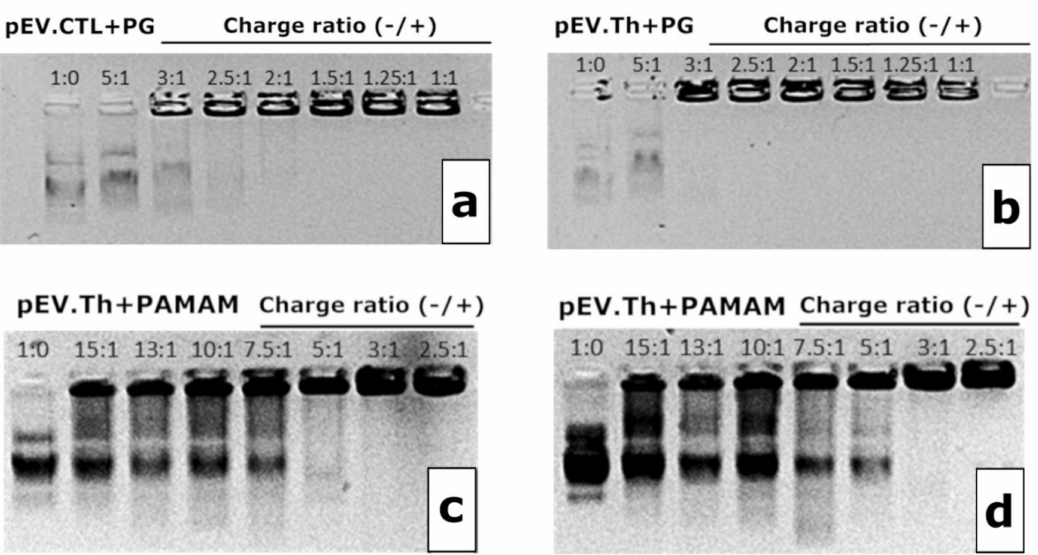
Figure 4. 1% Agarose gel electropherograms of pEV.CTL and PG complexes ( a ), pEV.Th and PG complexes ( b ), pEV.CTL and PAMAM complexes ( c ) and pEV.Th and PAMAM complexes ( d ). N:P ratio is indicated on the graphs.